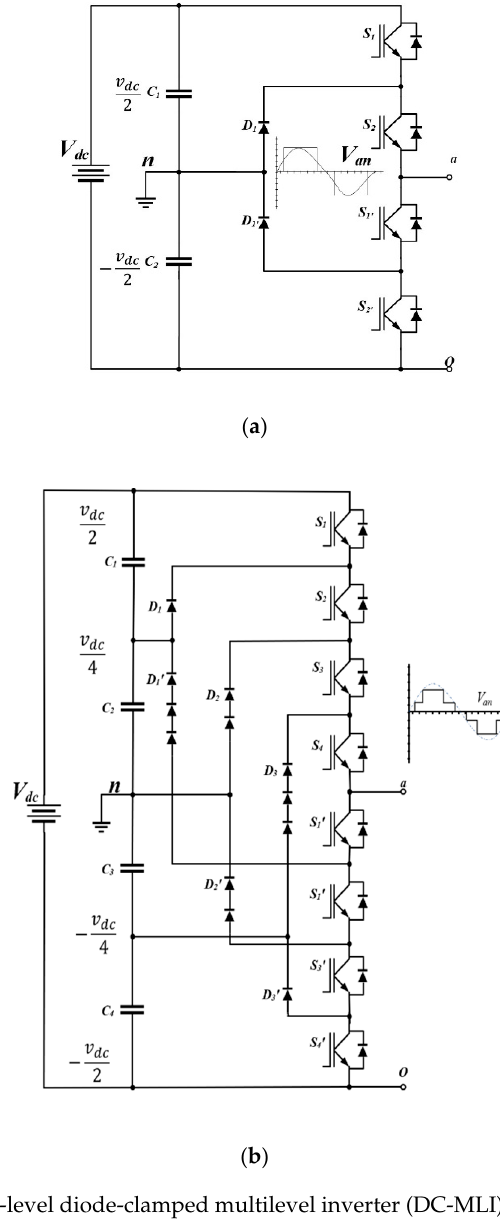
Figure 3. ( a ) Three-level diode-clamped multilevel inverter (DC-MLI); ( b ) 5-level DC-MLI.